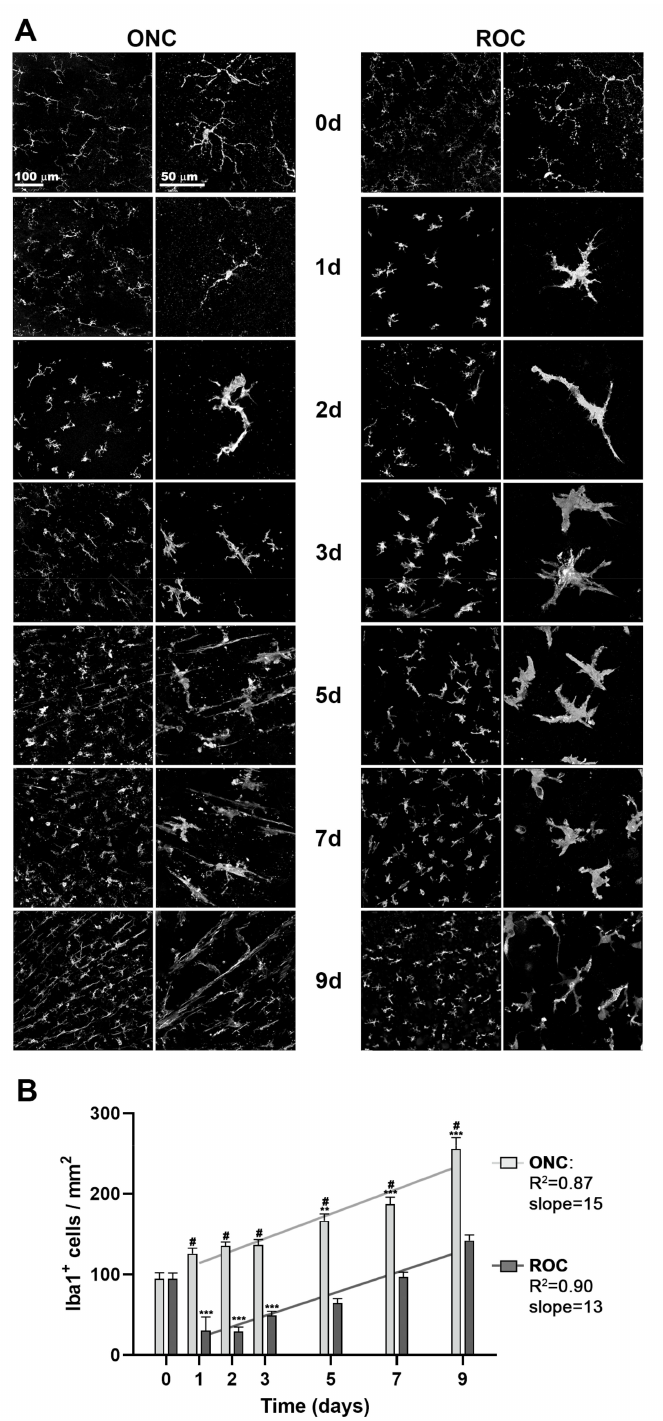
Figure 4. ROCs have a lower density of microglial cells in the GCL than axotomized retinas. ( A ) Rep- resentative magnifications from intact retinas (day 0) and retinas analyzed from 1 to 9 days after ROC and ONC showing Iba1+ microglial cells. ( B ) X- and Y-graphs (time versus cells) showing the mean ± SD density (cells/mm 2 ) of Iba1+ cells in both groups. Time 0 represents data from intact retinas. After a significant decrease in Iba1 + cells between day 0 and 1 in ROCs, data adjust to a linear regression from day 1 onwards. The slope between both models is significantly steeper after ONC than in ROCs ( p = 0.048). Experimental vs. intact (** p < 0.01, *** p < 0.001, Kruskal–Wallis test, Dunn’s multiple comparisons test); # ONC vs. ROC (# p < 0.001, Mann–Whitney test). n = 4–6 retinas/group/time